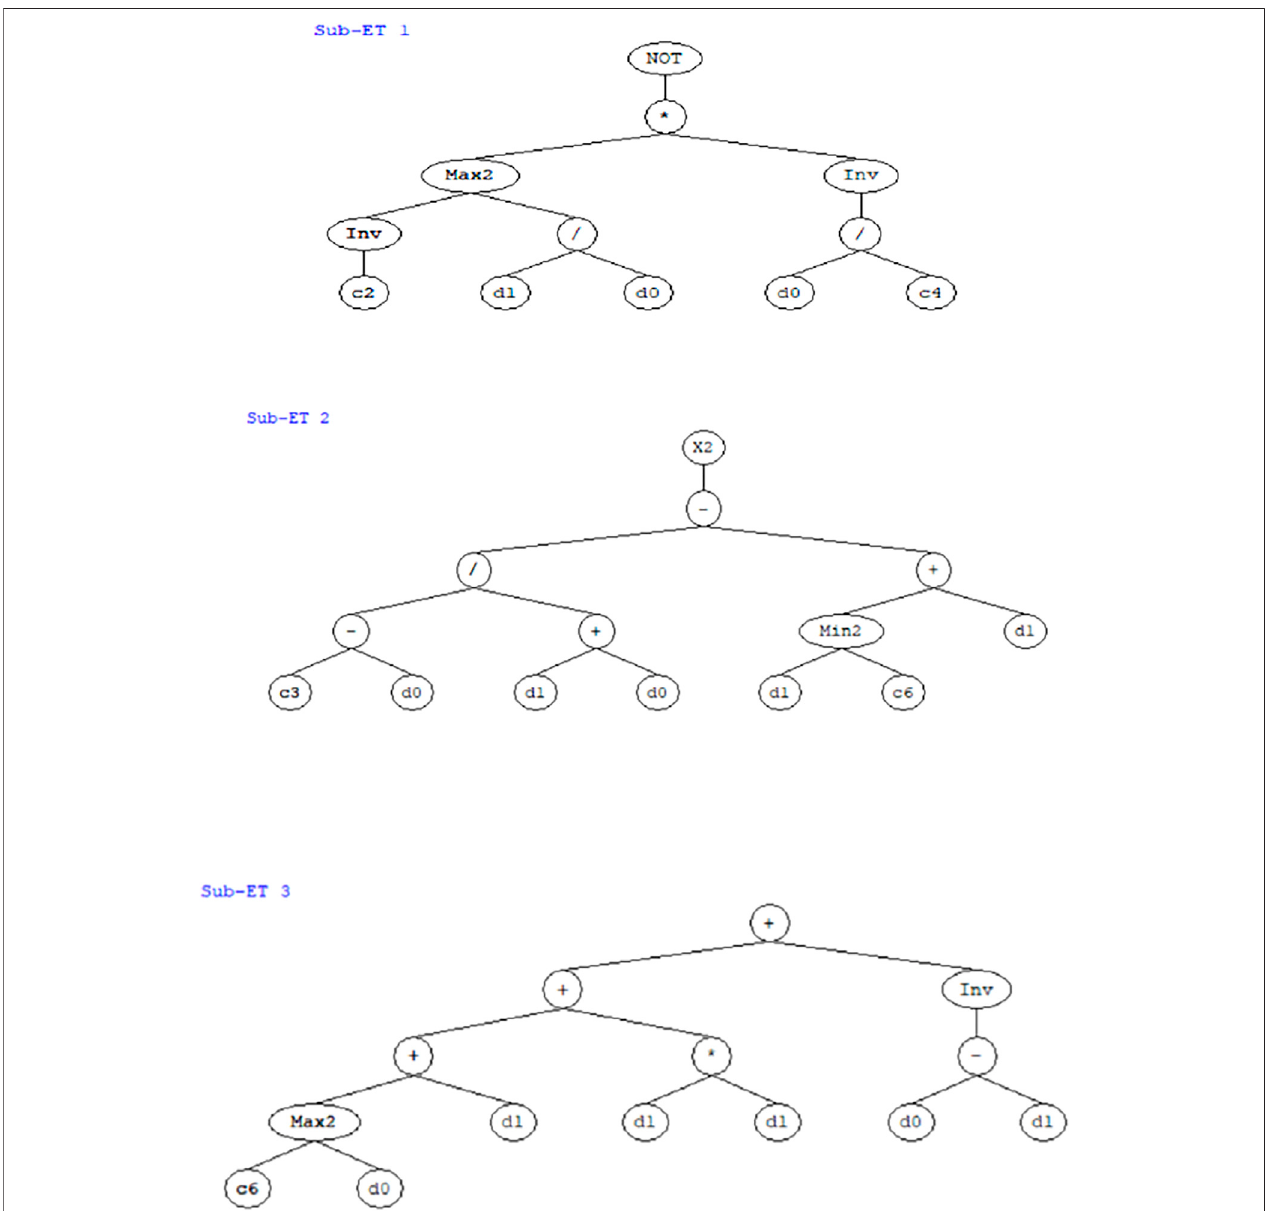
FIGURE 4 | The expression tree of PCI was obtained from the genetic programing software Genexpro 5.0 (d1: PSR, d0: IRI).